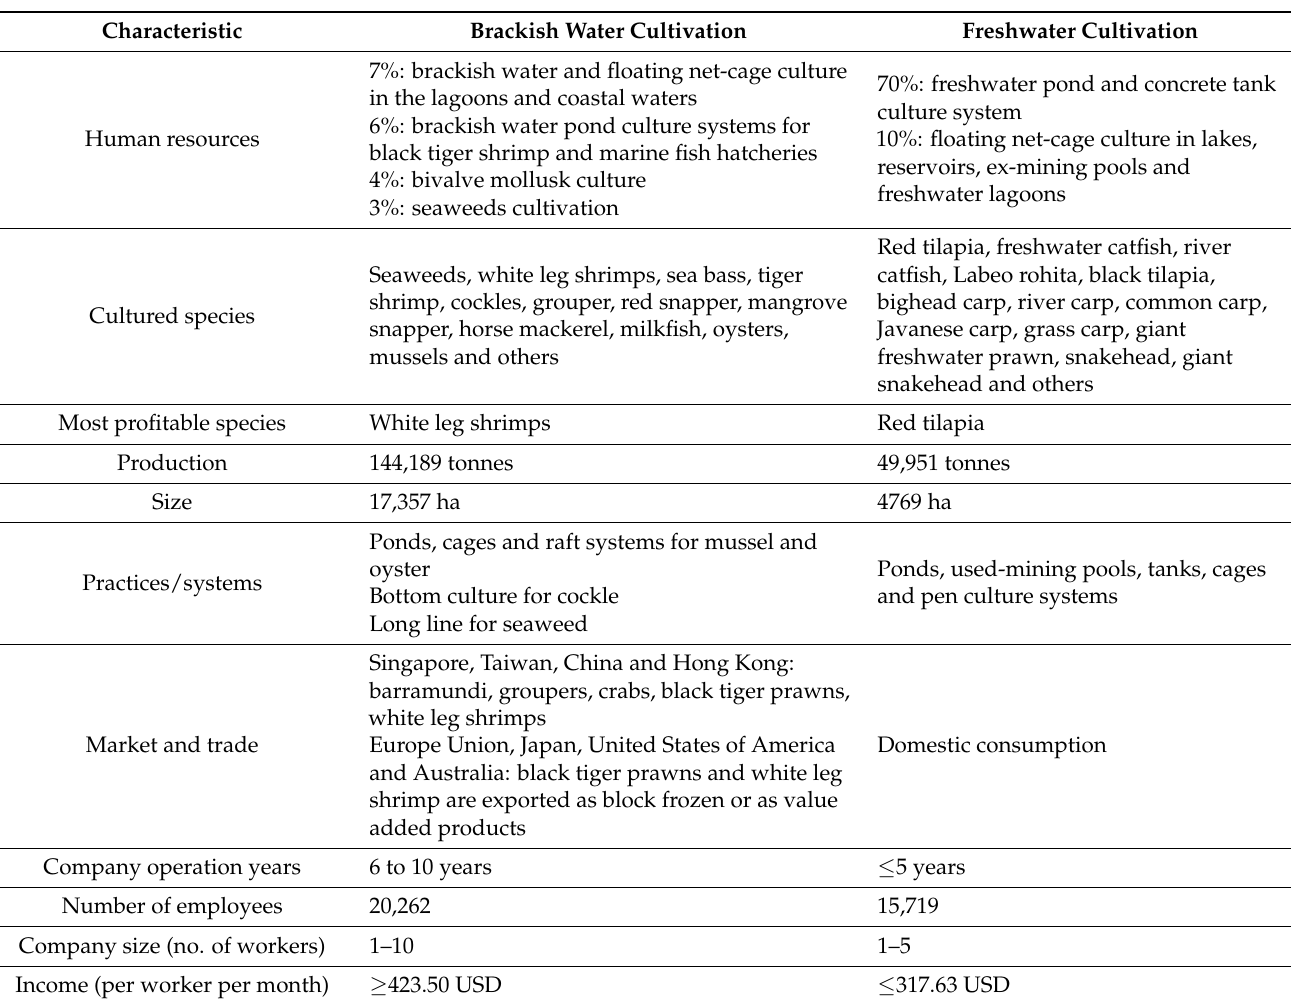
Table A1. Farming characteristics of the brackish water and freshwater aquaculture system in